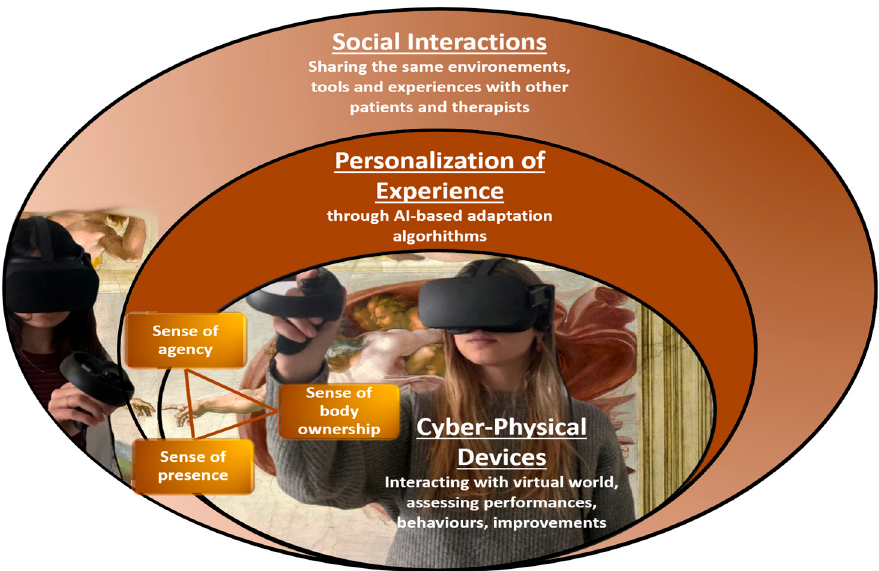
Figure 1. In this illustration, the application of the metaverse in clinical neurorehabilitation is presented as a hierarchical structure whose core is the infrastructure layer, consisting of a new set of wearable sensors and devices that enable the full continuum of physical–digital spaces and contributing to deeper immersive experiences. The personalization layer allows the integration of AI services and other distributed online capabilities, delivering the content of the metaverse therapeutic experience, which needs to be tailored to the specific clinical needs of the patient and adapted as much as possible to his/her individual characteristics. The highest layer allows for social interaction, through web connections, among patients and therapists but also caregivers and familiars, allowing for sharing environments, tools, experiences and data. In this schema, the sense of body ownership is related to the lowest personal layer, the sense of agency links it to the personal experience in the virtual world and the sense of presence refers to own presence but also to the presence of other people in social